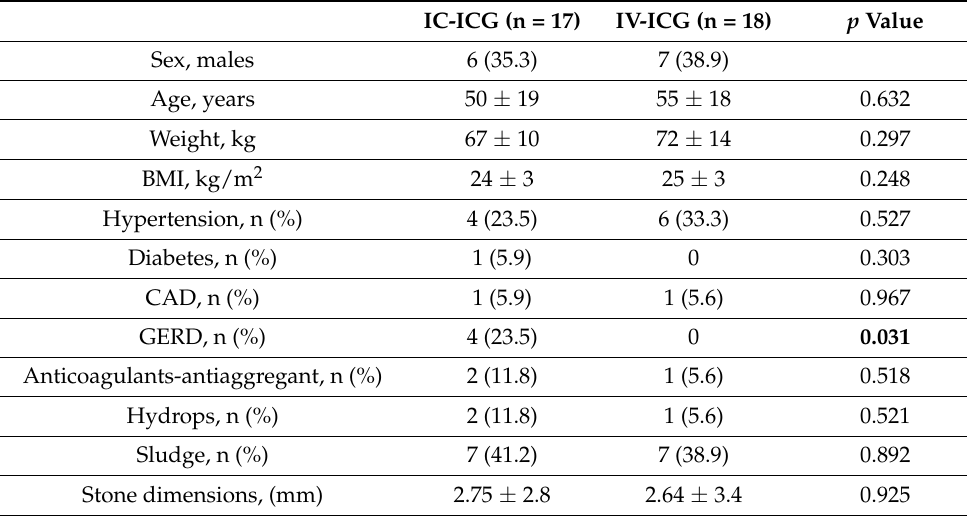
Table 1. Demographic and preoperative features of the study